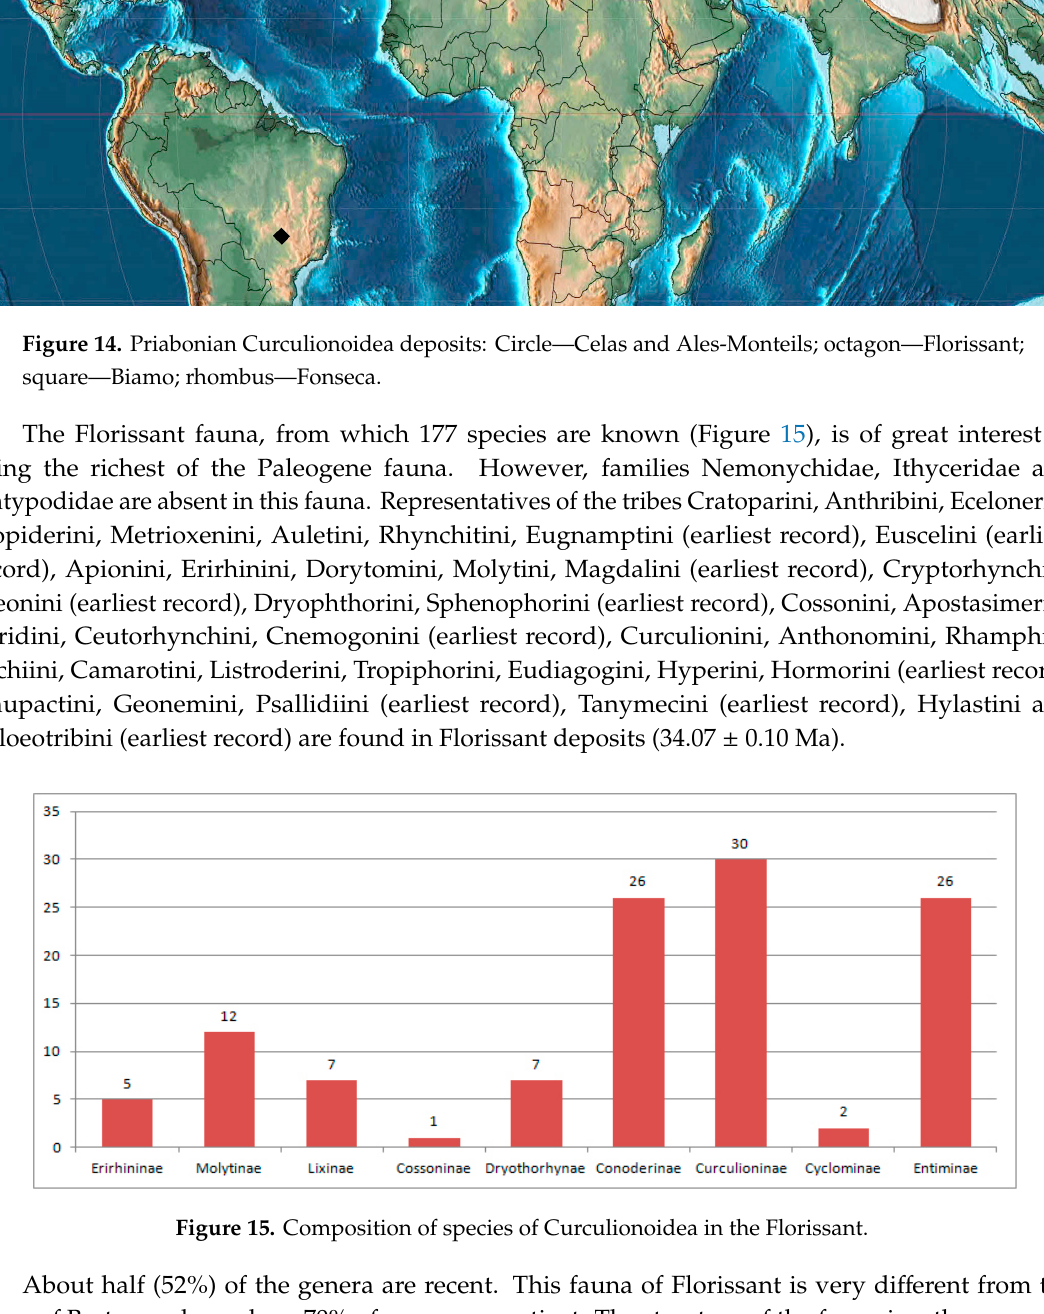
Figure 16. Composition of species of Curculionidae in the Florissant.